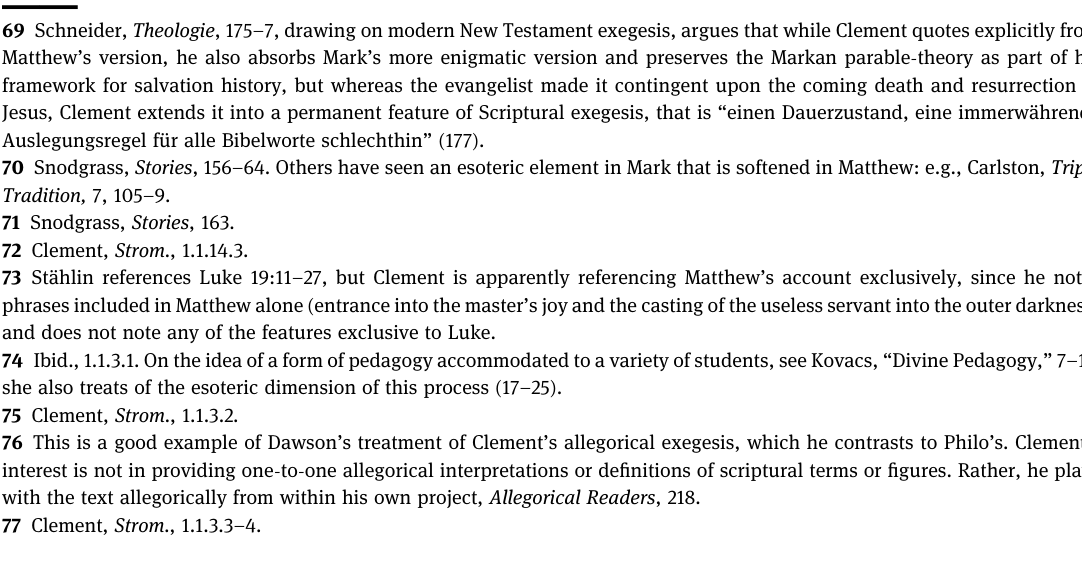
phrases included in Matthew alone ( entrance into the master ’ s joy and the casting of the useless servant into the outer darkness ) and does not note any of the features exclusive to Luke.